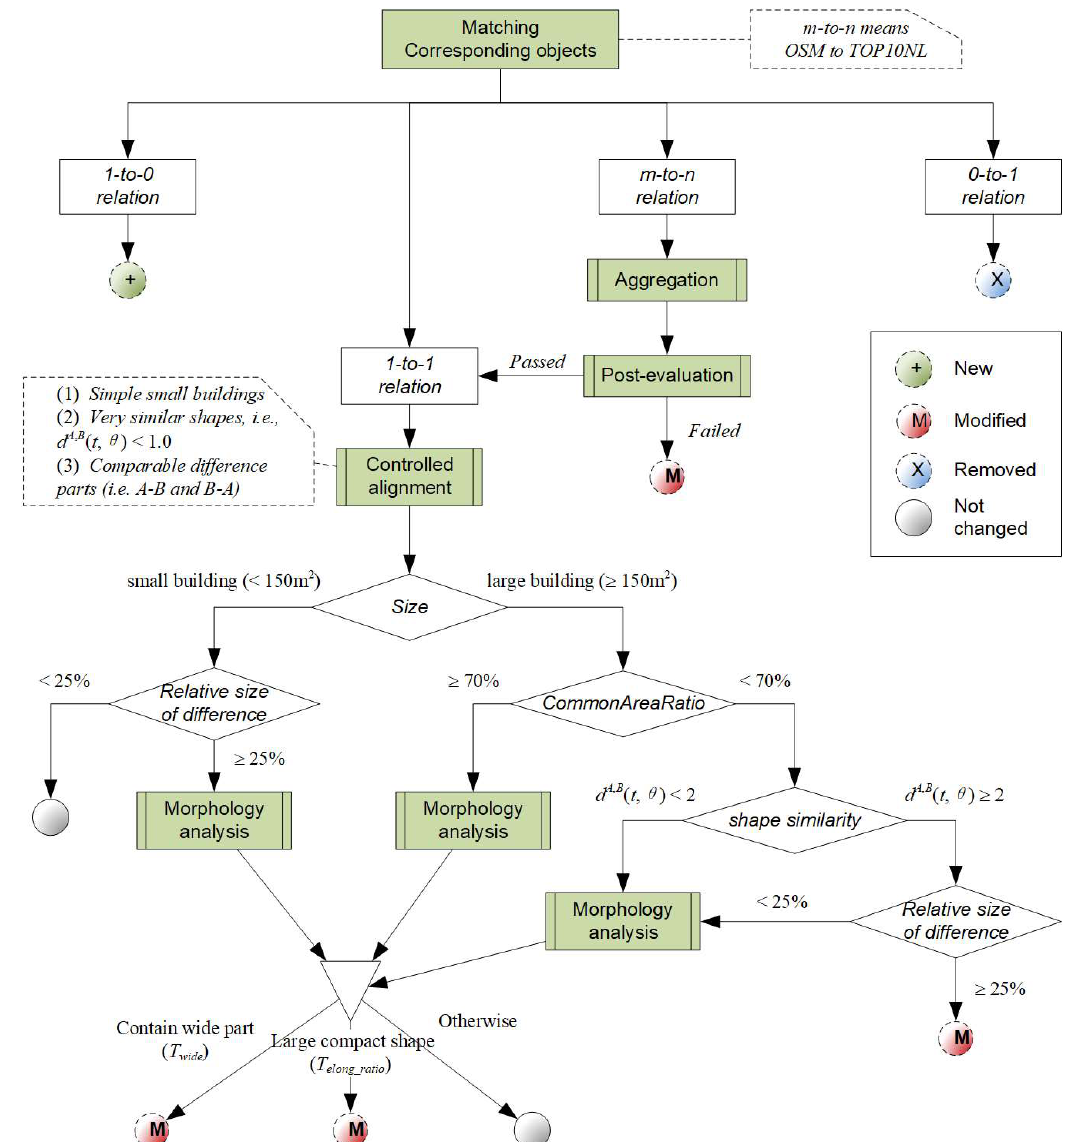
Figure 8. The outline of our rule system for change detection (rules and operations are mixed in the directed acyclic graph structure); the shaded boxes are operations detailed in Sections